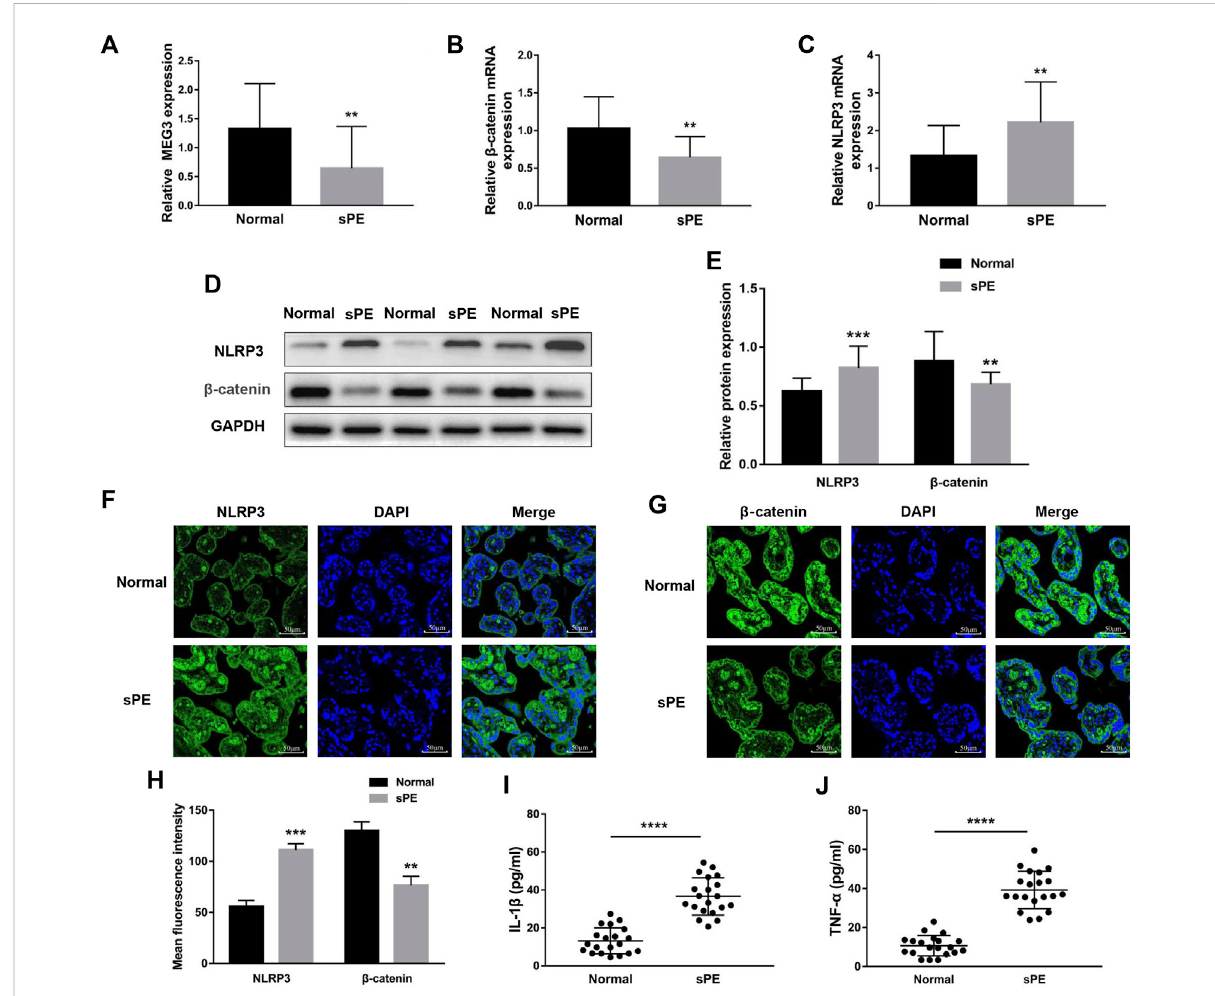
FIGURE 1 Expression of MEG3 , β -Catenin and NLRP3 in the placentas of normal pregnancies and sPE patients. The relative mRNA levels of MEG3 (A) , β - Catenin (B) and NLRP3 (C) were assessed by qRT ‒ PCR. (D,E) The relative protein levels of β -Catenin and NLRP3 were detected by Western blot. GAPDH was used as an endogenous control. The expression levels of NLRP3 (F) and β -Catenin (G) in placental tissues were evaluated by immuno fl uorescence (IF). (H) Semi-quantitative analysis of mean fl uorescence intensity. The serum levels of IL-1 β (I) and TNF- α (J) were detected by ELISA. n = 20/group. ** p < 0.01; *** p < 0.001; **** p <